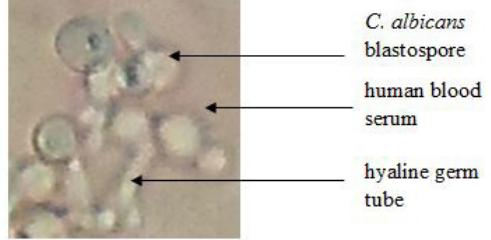
Figure 1: Germ tube formation of C. albicans in blood serum (magnification: 2 × 10 ×